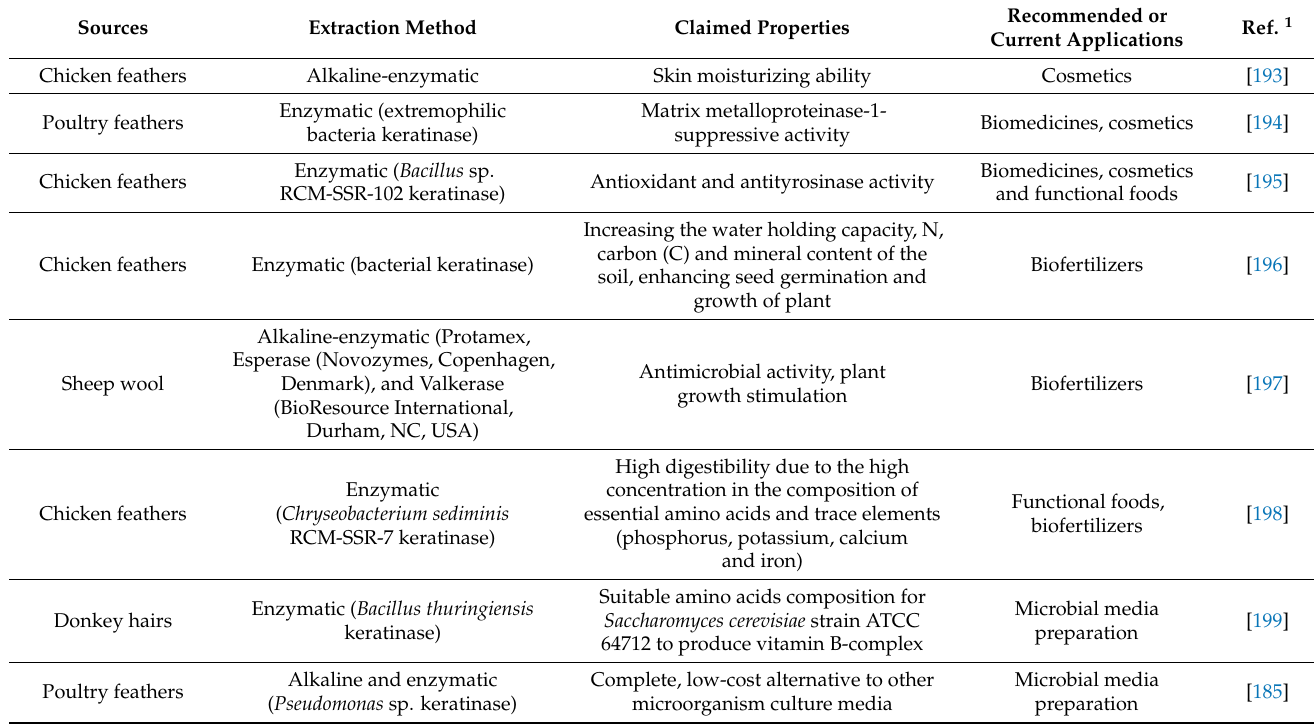
Table 4. Characteristics and applications of keratin